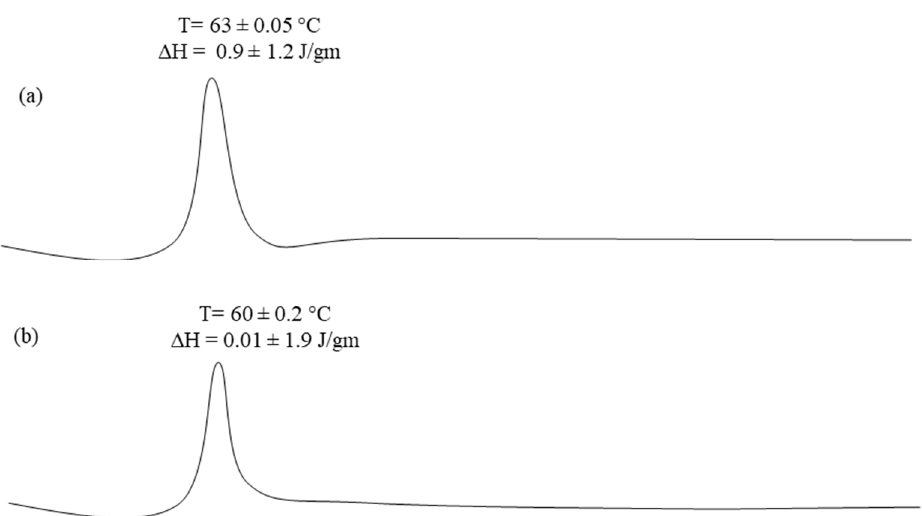
Figure 1. DSC thermo grams of ( a ) Pure Capsaicin and ( b ) T3 Capsaicin loaded nano-crystal formu- lation.